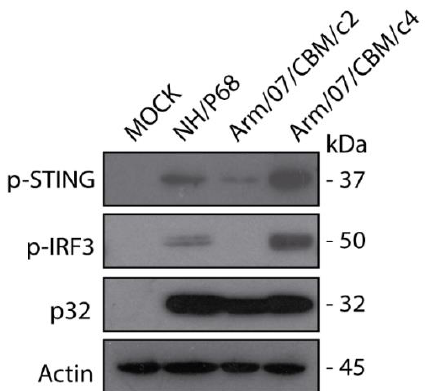
Figure 8. Arm/07/CBM/c2 but not Arm/07/CBM/c4, prevented STING and IRF3 phosphorylation in PAM. PAMs were mock-infected or infected with either Arm/07/CBM/c2, Arm/07/CBM/c4 or NH/P68 strains for 16 h using MOI = 0.5. Cells were lysed in RIPA buffer and lysates were separated by 7–20% SDS-PAGE, followed by immunoblotting with anti-pSTING, anti-p-IRF3, anti-p32 and anti-Actin.